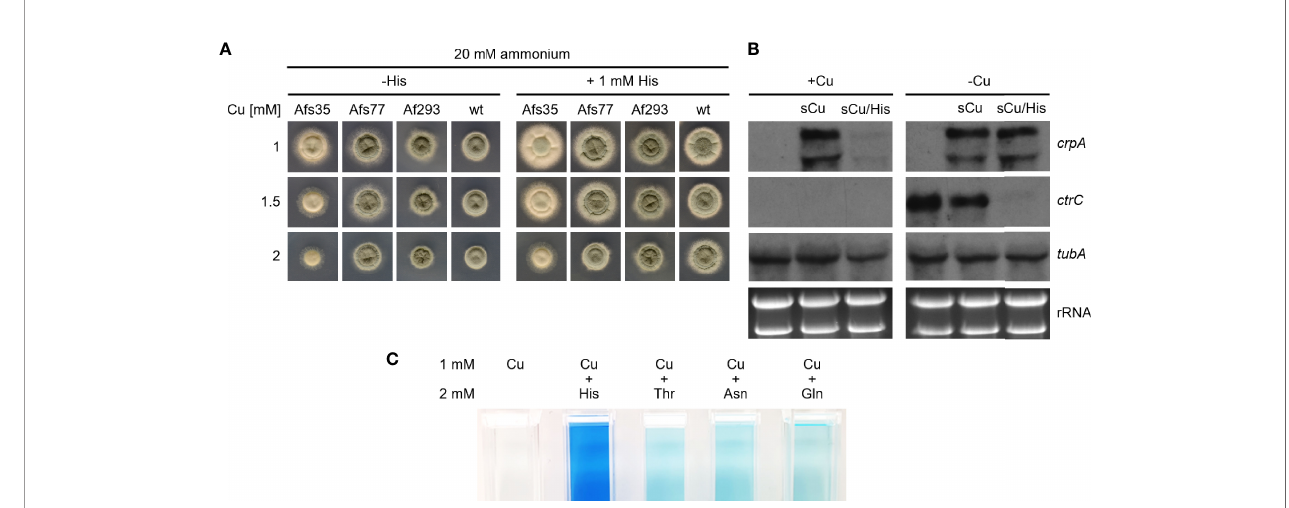
FIGURE 6 | His supplementation protects A. fumigatus wt by inhibition of His uptake. (A) A. fumigatus conidia were point-inoculated on AMM plates with 20 mM ammonium as nitrogen source containing different Cu concentrations without (-His) and with 1 mM His supplementation. The plates were incubated for 48 h at 37°C. (B) A. fumigatus wt was grown for 16 h at 37°C in AMM liquid cultures with ammonium as nitrogen source without (-Cu; Cu limitation) and with (+Cu, Cu suf fi ciency) 0.005 mM Cu, respectively. Subsequently, the mycelia were harvested or incubated for another 45 min after addition of Cu to a fi nal concentration of 0.2 mM without (sCu) or with (sCu/His) concomitant addition of His to a fi nal concentration of 2 mM. Notably, Cu and His have been mixed before the addition to allow Cu – His complex formation. After harvesting the mycelia, total RNA was isolated and subject to Northern analysis of the indicated genes. Ethidium bromide-stained rRNA and a -tubulin encoding tubA served as controls for loading and quality of RNA. As observed previously (Wiemann et al., 2017), crpA has two transcripts, which are slightly larger and smaller as the 26S rRNA. (C) His, Thr, Asn, and Gln form colored complexes with Cu. The photos show cuvettes with 1 mM Cu or 1 mM Cu mixed with 2 mM of the indicated AA.